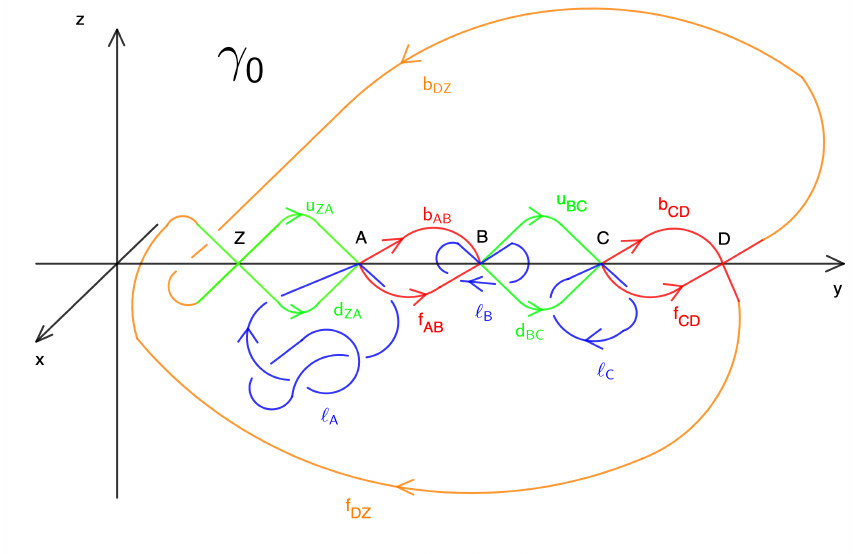
Figure 1. The parent graph. Green lines are in the y,z plane and red lines are in the x,y plane. Orange lines interchange between these planes. The u (d) lines have positive (negative) z coordinates, while the f (b) lines have positive (negative) x coordinates. The blue loops are tangent to edges at their endpoints as